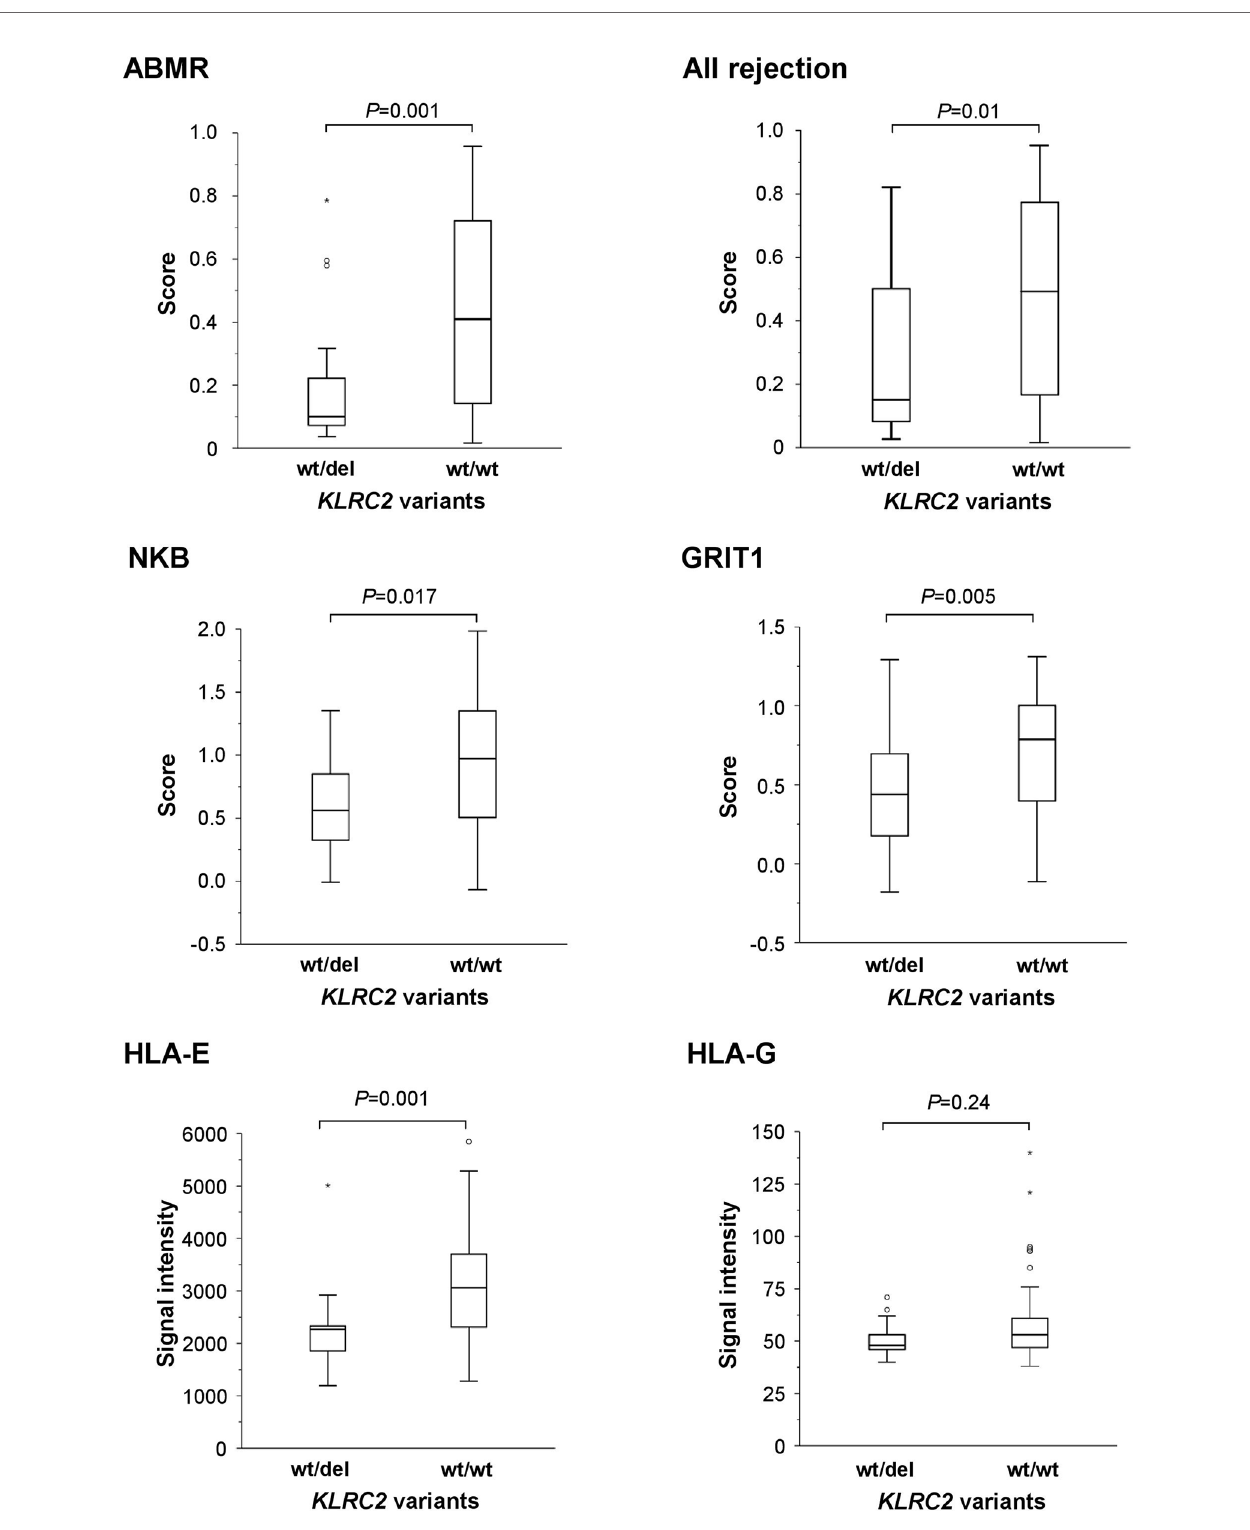
FIGURE 3 | KLRC2 polymorphism in the DSA+ BORTEJECT cohort in relation to molecular rejection-related scores (ABMR, ‘ all rejection ’ ), NK cell burden (NKB)- and IFN-y-related transcripts (GRIT1), or expression of HLA-E and HLA-G (microarray signal intensity). Box plots represent the median, interquartile range and range. Outliers are indicated by circles and extreme outliers by